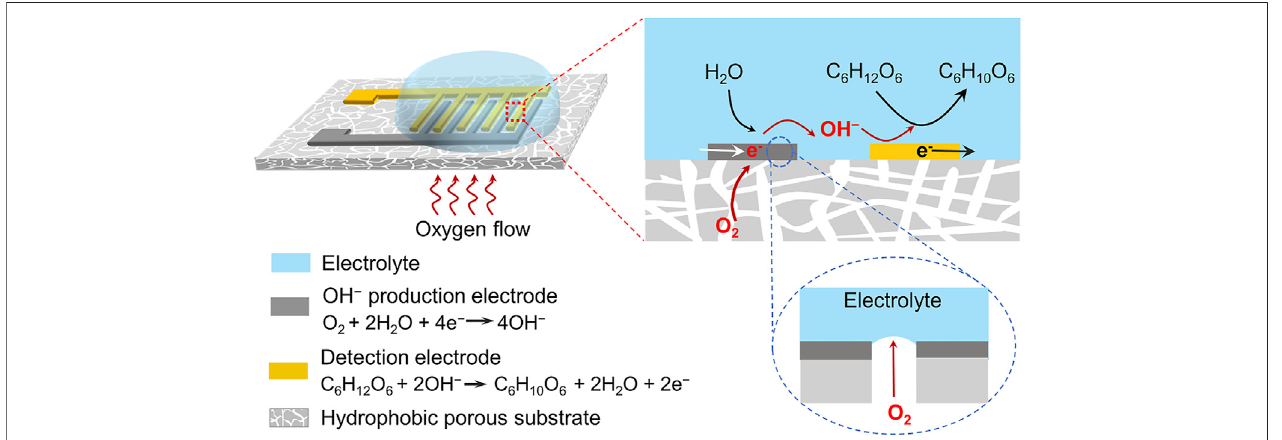
FIGURE 1 | Schematic illustration of the triphase non-enzymatic sensor. The sensor consists of a hydrophobic porous substrate, an electrode for local alkalinity generation via oxygen reduction reaction, and an electrode for electrocatalytic glucose oxidation reaction. Suf fi cient oxygen supplied from the air phase was reduced to OH − atthetriphaseinterface,leadingtoahighinterfacepHforelectrocatalyticglucoseoxidation.Theelectrodearchitecturemakesthenon-enzymaticglucosedetection independent of the solution pH. During the experiment, a negative potential was fi rst applied to the OH − production electrode to generate a local alkaline microenvironment, and then a positive potential was applied to the detection electrode for electrochemical glucose oxidation.